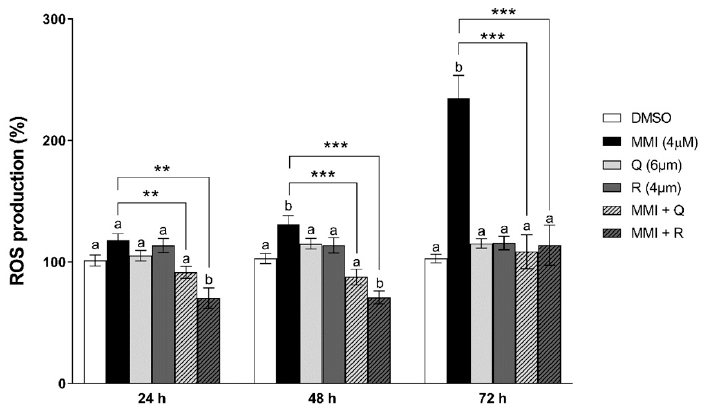
Figure 3. Effects of MMI, Q, and R on ROS production in CRFK cells, measured with the DCFH-DA assay. Cells were exposed to MMI (4 µ M) in the presence or absence of either Q (6 µ M) or R (4 µ M) for 24, 48, and 72 h. Results are expressed as a percentage of ROS production compared with the solvent control (0.1% DMSO). Data are represented as mean ± SEM of three independent experiments and analyzed by one-way ANOVA followed by Sidak’s test. Different letters indicate statistical differences compared with control cells ( p < 0.05). Statistical differences with respect to the cells treated with MMI alone are reported (** p < 0.01, *** p < 0.001).